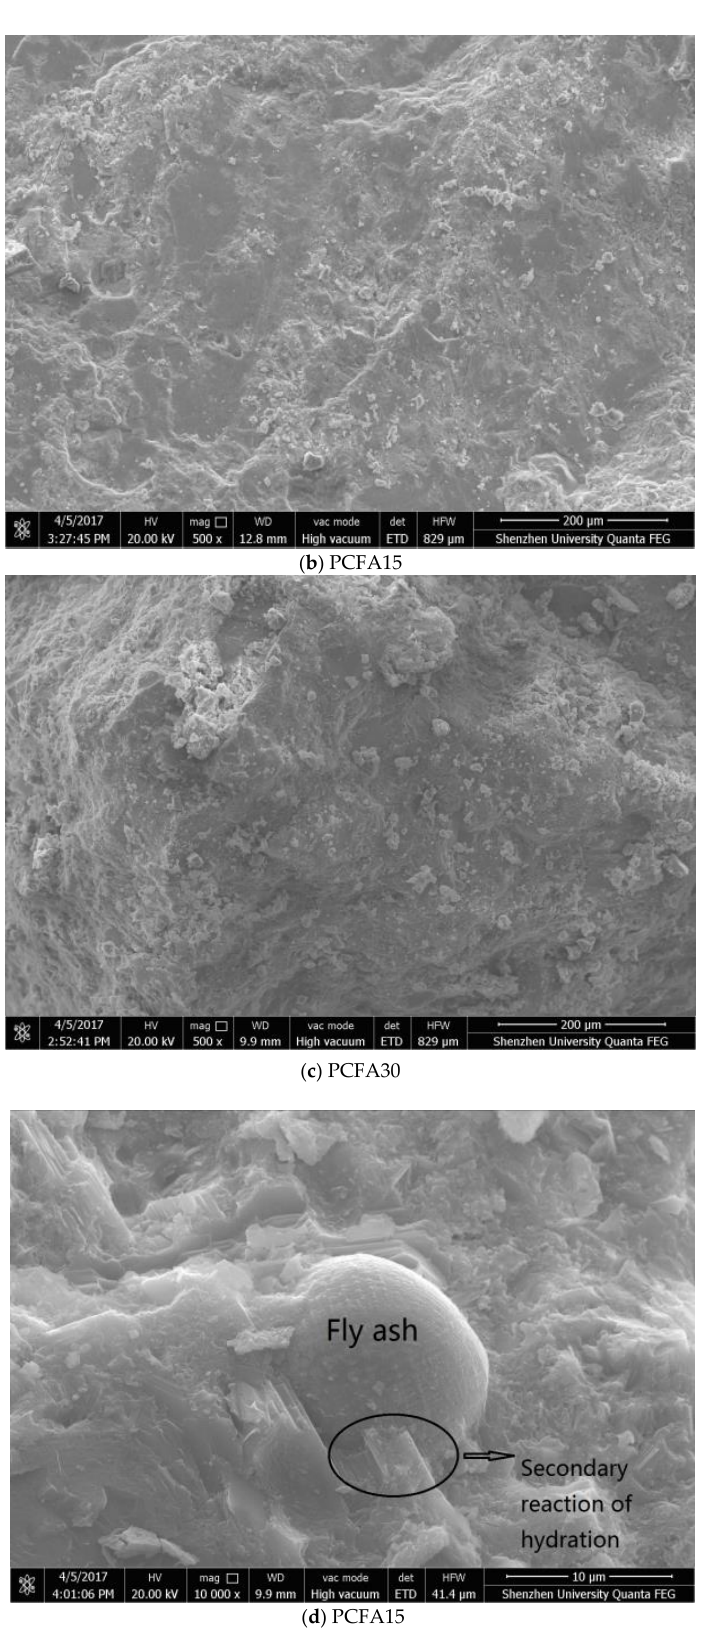
Figure 12. Morphologies of concrete samples with different fly ash additions after 90 days of curing.